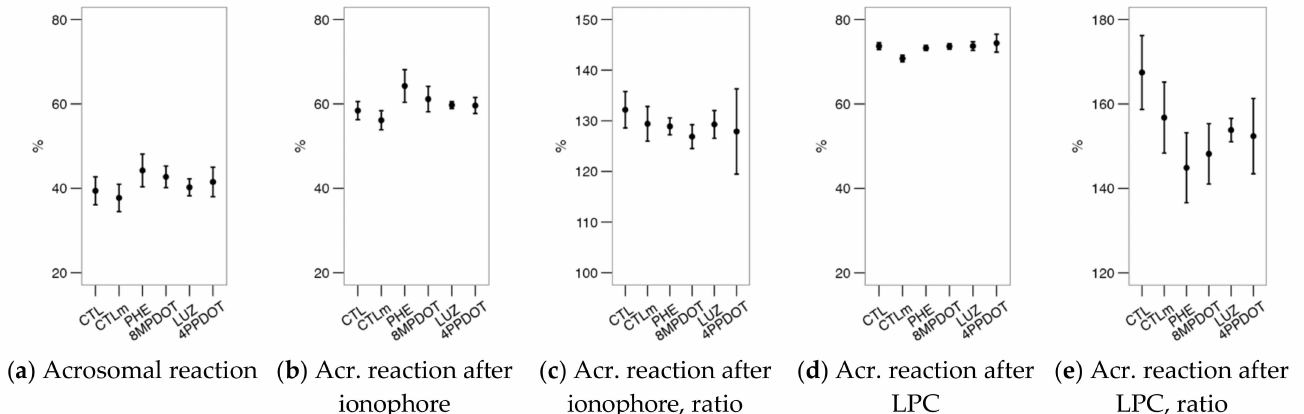
Figure 8. Effects on red deer epididymal sperm acrosomal reaction (within the viable population) of melatonin receptor agonists (PHE: Phenylmelatonin; 8MPDOT: 8-Methoxy-2- propionamidotetralin) or antagonists with 10 nM melatonin (LUZ: Luzindole; 4PPDOT: cis-4- Phenyl-2-propionamidotetralin); CTL: Control; CTLm: Control with 10 nM melatonin. Plots show mean ± SEM for each treatment of five males. ( a ) Acrosomal reaction (PNA − cells) as the ratio of the viable sperm population (PI − ), ( b ) after ionophore treatment and ( c ) as a ratio of the values after ( b ) and before ( a ) the challenge, and ( d ) after lysophosphatidylcholine (LPC) treatment and ( e ) as a ratio of the values after ( d ) and before ( a ) the challenge. No significant differences were found among treatments.